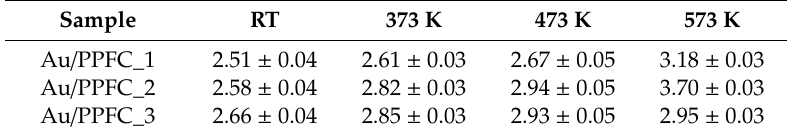
Table 4. Evaluated indirect band gap energy (in eV) for three multilayers at di ff erent